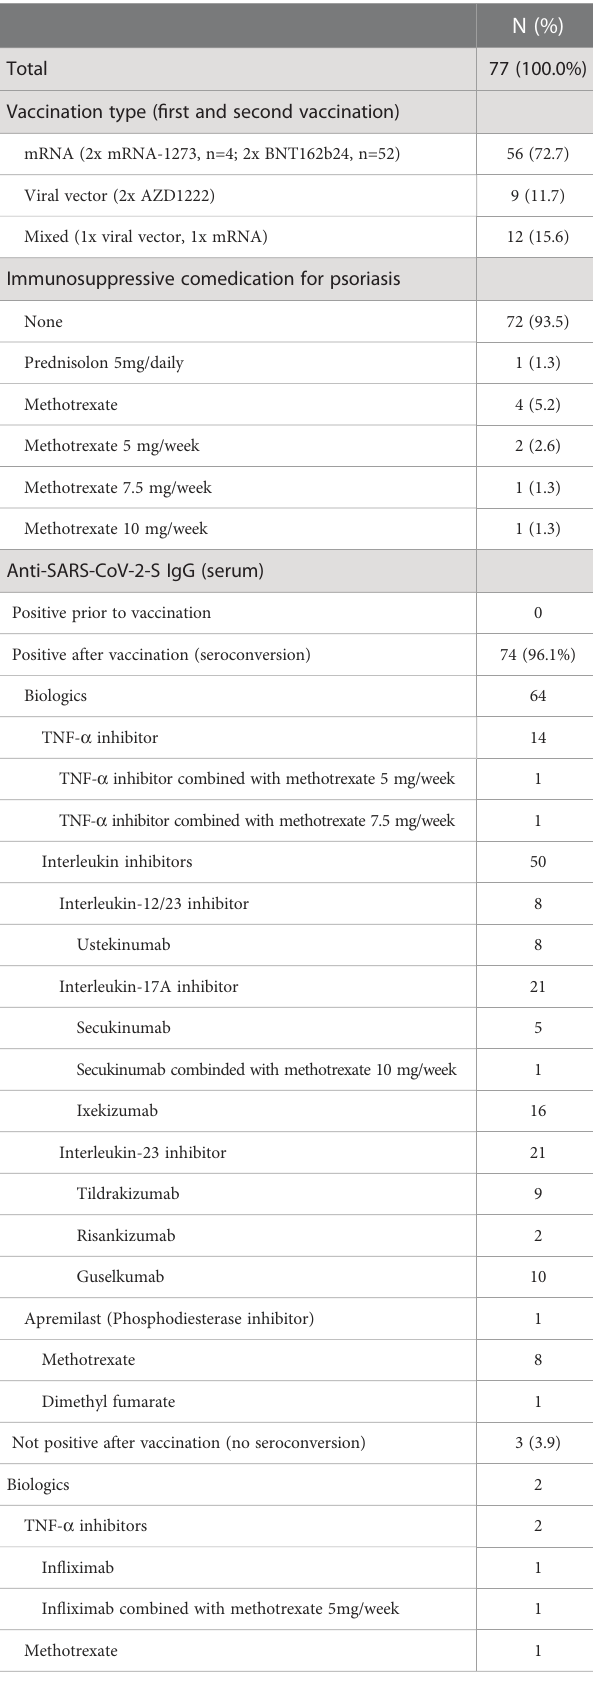
TABLE 2 COVID-19 vaccination and